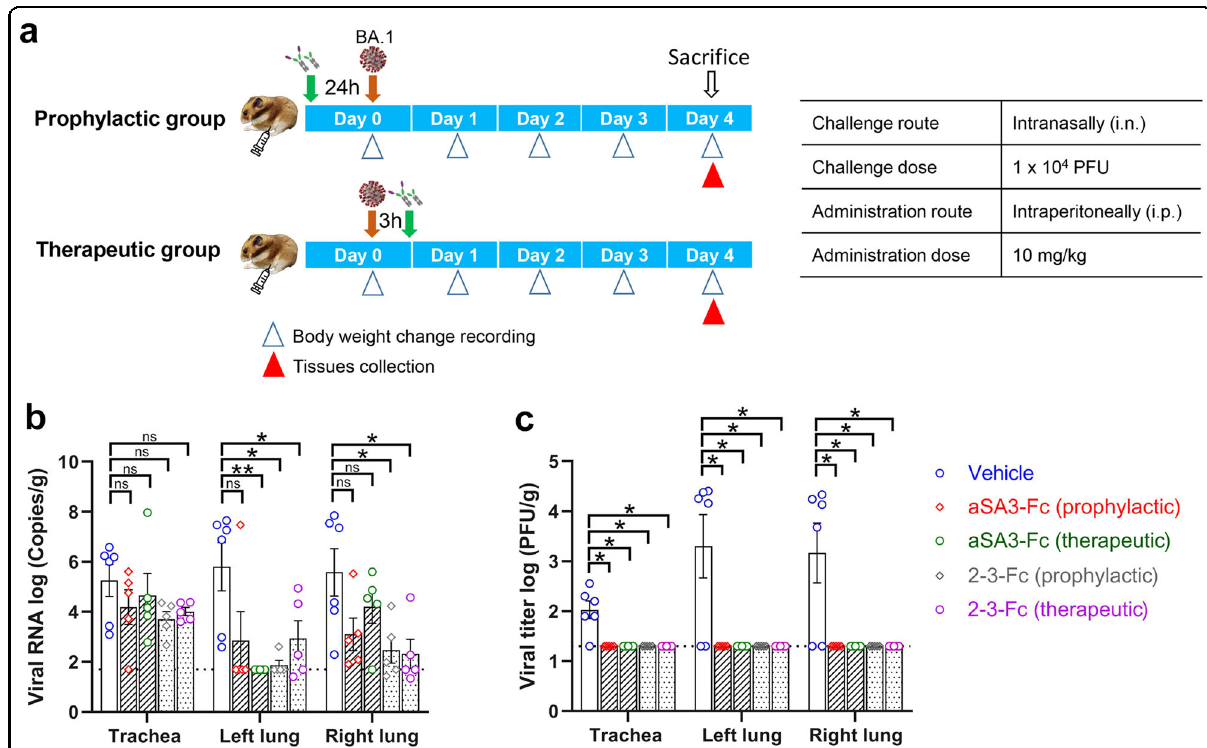
Fig. 4 aSA3-Fc and 2-3-Fc provide prophylactic and therapeutic protection against Omicron BA.1 in hamsters via i.p. administration. a Animal experiment scheme. b , c Syrian hamsters were divided into fi ve groups that were treated with vehicle (PBS) ( n = 6), aSA3-Fc ( n = 5) and 2-3- Fc ( n = 5) before or after the i.n. challenge with Omicron BA.1 virus. At 4 dpi, viral RNA copies ( b ) and viral titers of infectious virus ( c ) in the trachea and lungs of hamsters were measured with qPCR and plaque assays, respectively. Error bars indicate the means ± SEM. The animal experiment was performed in parallel and shared the vehicle control group with our another study 24